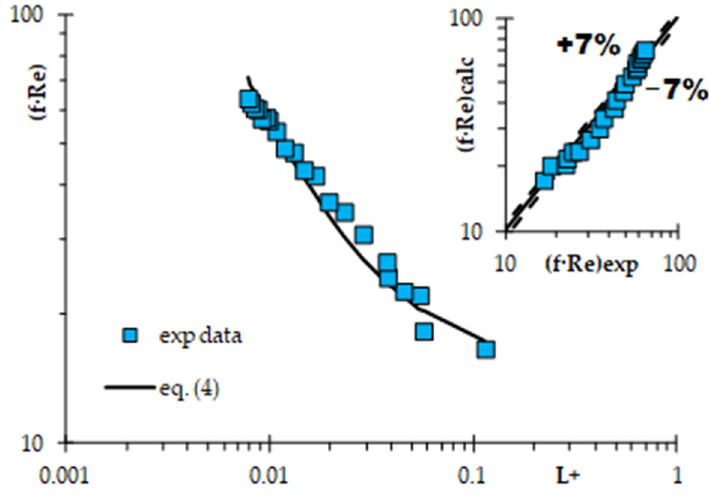
Figure 2. Flow resistance for hexagonal channel tested. Inset: parity plot for Equation (4).